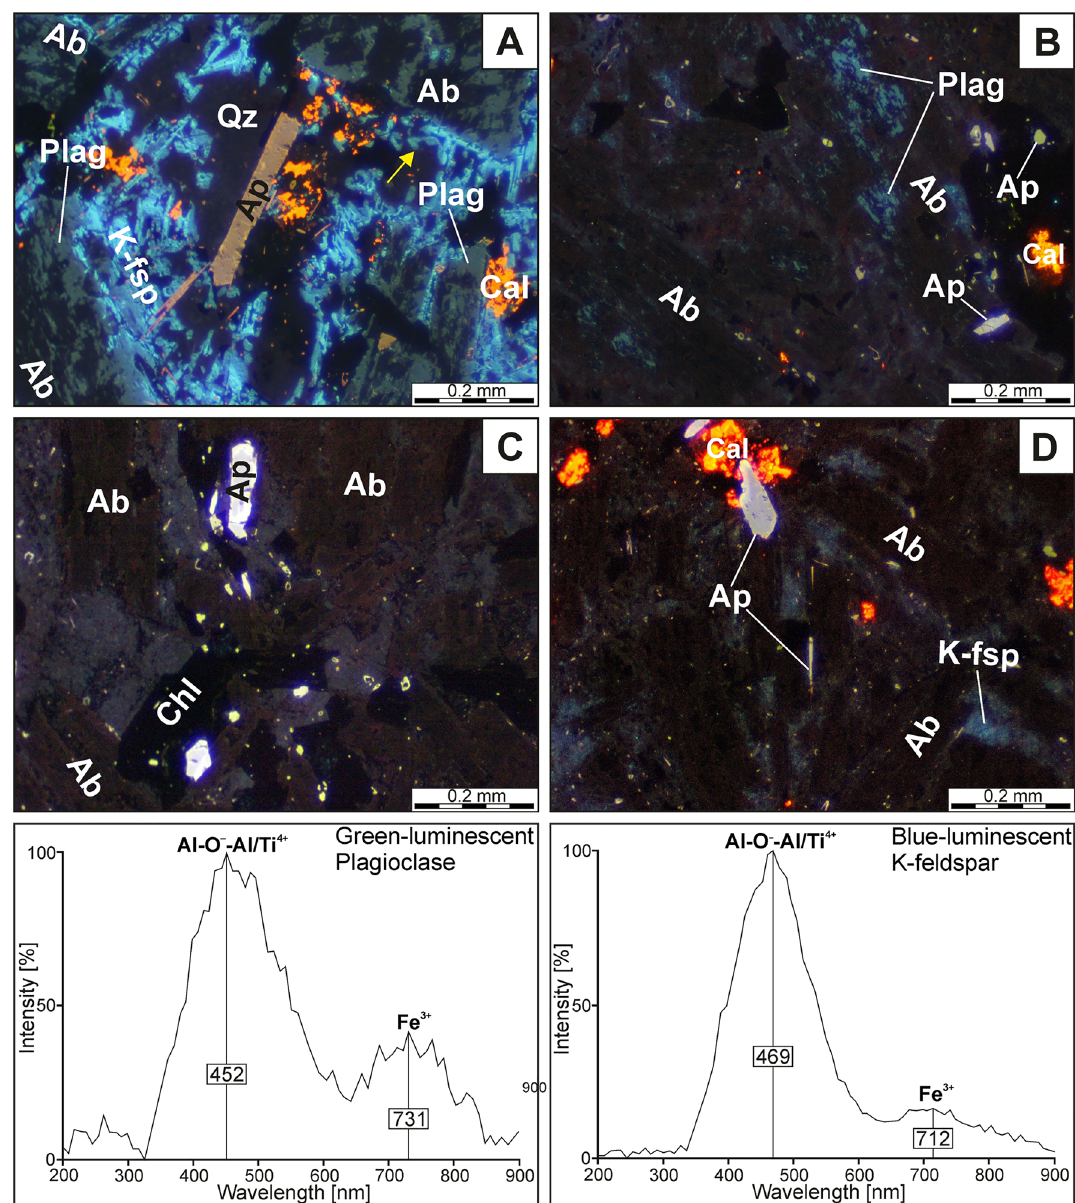
Figure 6. Variable stages of albitization developed within Głuszyca trachyandesites revealed using OM-CL technique. ( A ) Incipient albitization marked by the occurrence of pure, weak to dark-brown luminescent albite (Ab) patches invading primary greenish-gray luminescent plagioclase host (andesine-labradorite) (Plag); Note that albitized andesine-labradorite is rimmed by relatively fresh blue-luminescent K-feldspar (K-fsp) showing embayed grain contacts with interstitial weakly-luminescent quartz (yellow arrow)—Loc. 1. ( B ) Progressive albitization of primary andesine-labradorite (Plag) (Loc. 1). ( C, D ) Complete replacement of andesine- labradorite by brown-luminescent secondary albite (Ab) in the samples from the middle (Loc. 2) and upper (Loc. 3) parts of the laccolith from Głuszyca, respectively. Note that CL spectra of greenish-gray luminescent plagioclase and bright-blue luminescent K-feldspar in the spectral range of 200–900 nm were shown at the bottom of the